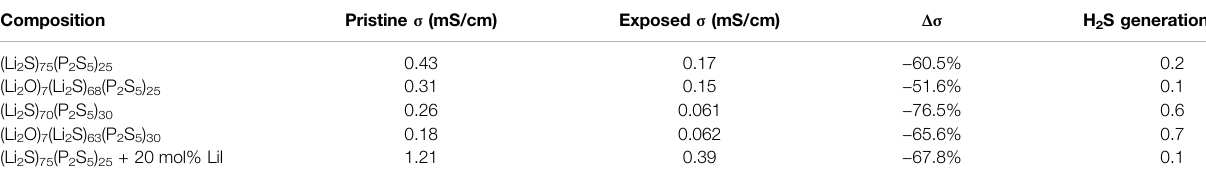
TABLE 1 | Ionic conductivity and H2S generation data for sul fi de SSE powders exposed to a − 40 ° C dew point dry room environment for 30 min. Composition